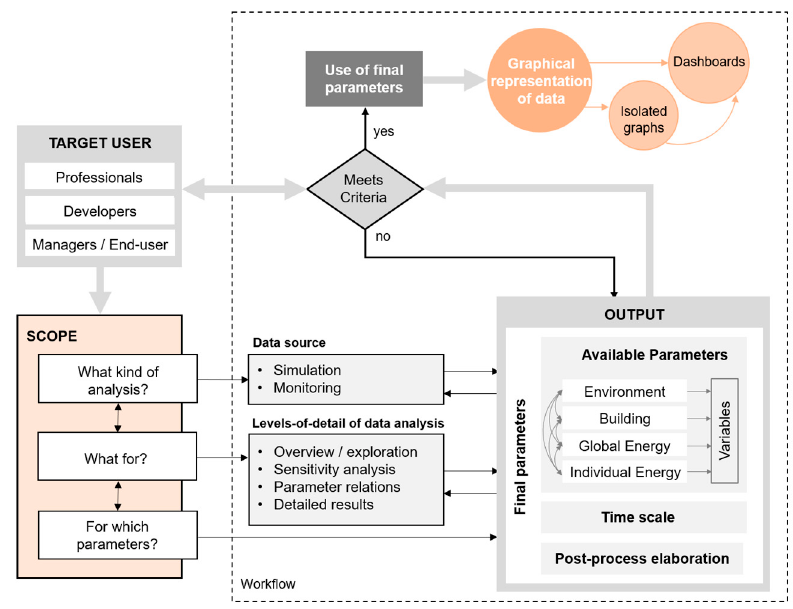
Figure 3. Workflow to identify the most suitable graphical representation of data.